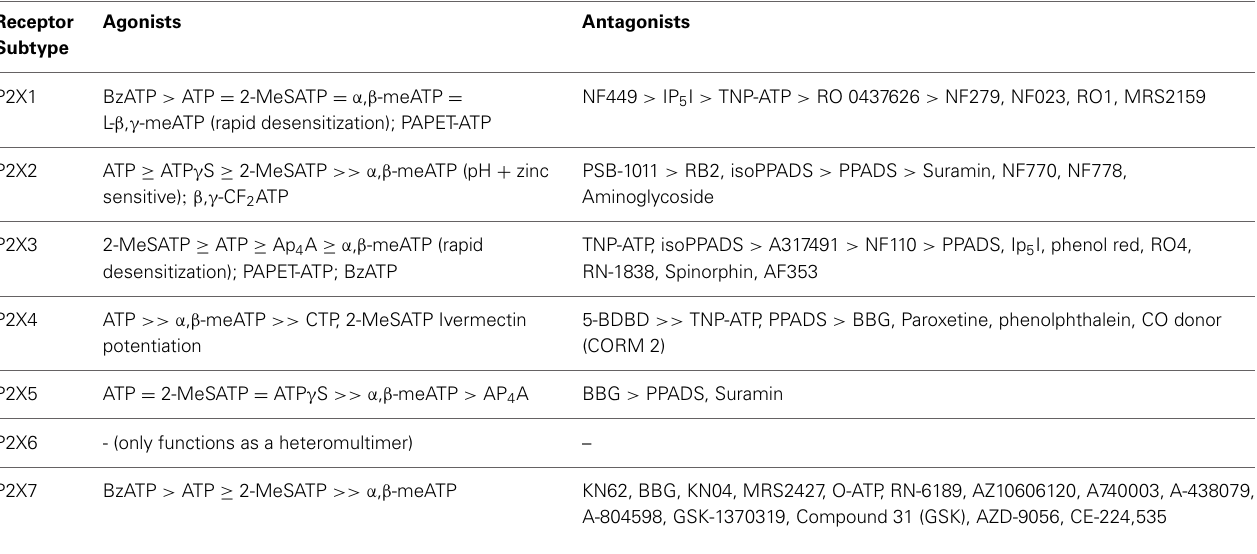
Table 2 | Agonists and antagonists for the different P2X receptor